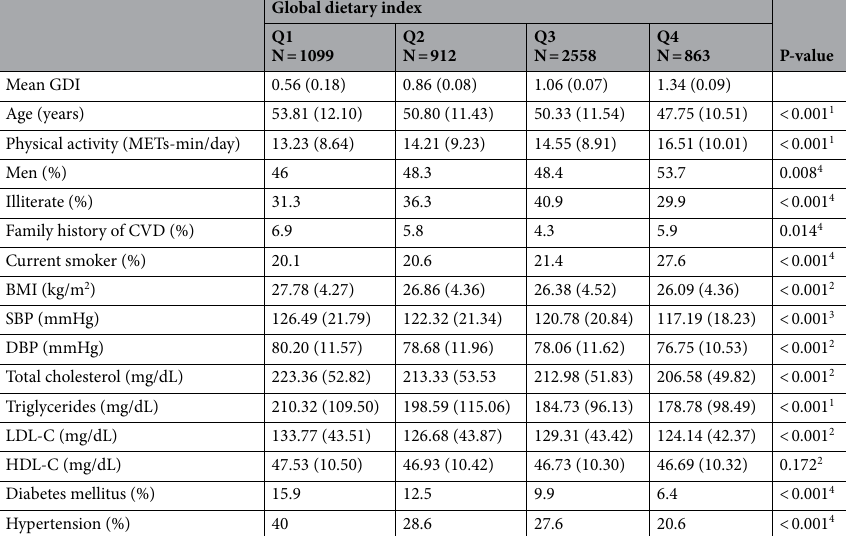
Triglycerides (mg/dL)